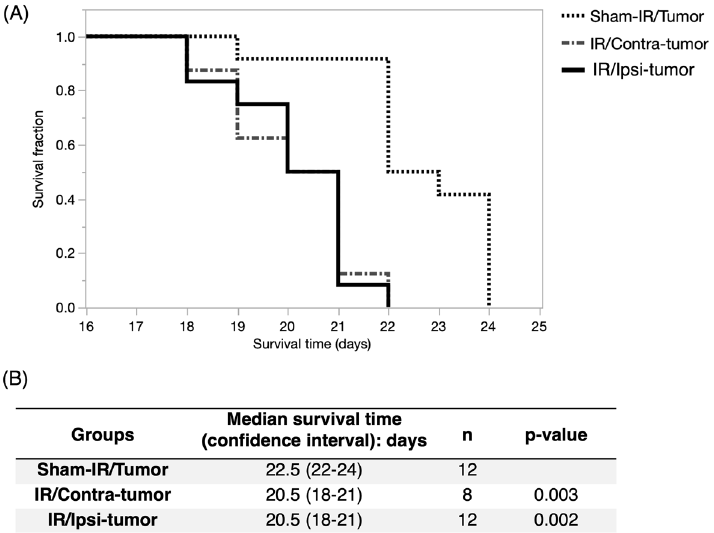
Figure 2. ( A , B ) Survival curves of Fischer rats implanted with F98 glioma cells. Significantly shorter median survival times were achieved by the IR/Ipsi-tumor and IR/Contra-tumor rats compared to the Sham-IR/ Tumor rats (IR/Ipsi-tumor and IR/Contra-tumor = 20.5 days vs Sham-IR/Tumor group = 22.5 days; p = 0.002 and p = 0.003, respectively). There was no significant difference in survival between the IR/Ipsi-tumor and IR/ Contra-tumor groups (p =